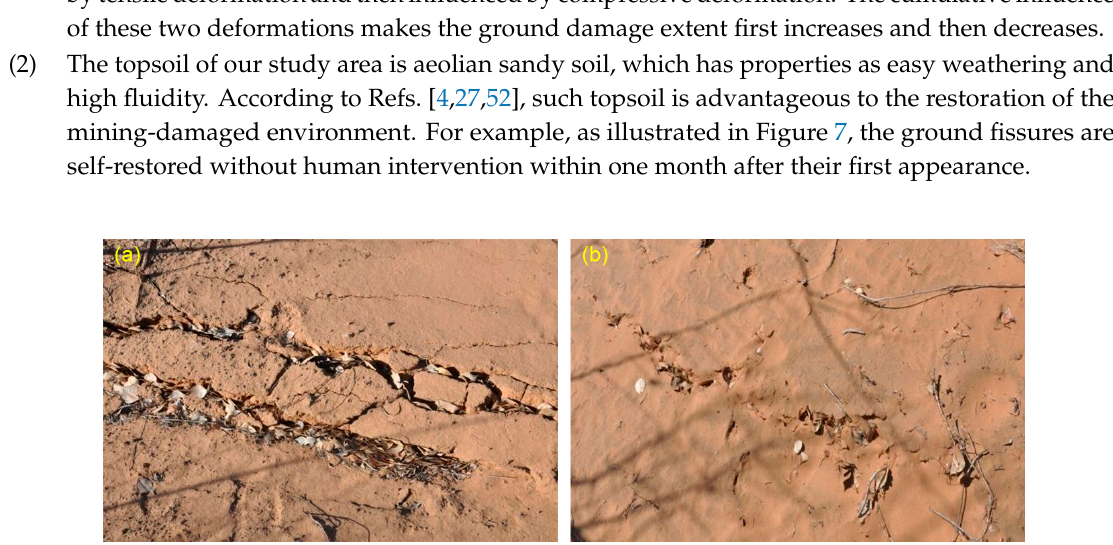
Figure 7. Self-restoration of mining-induced fissures in the Shendong coalfield [52] : ( a ) the mining- induced ground fissures; ( b ) the self-restored ground fissures at the same site.